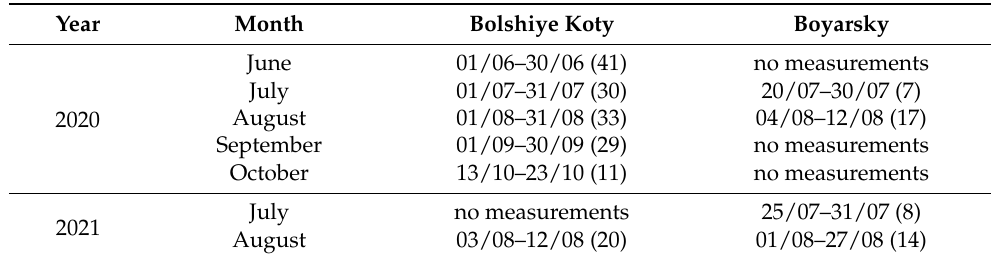
Table 1. Atmospheric aerosol sampling periods at the Bolshiye Koty and Boyarsky research stations in 2020 and 2021 (the number of samples is given in